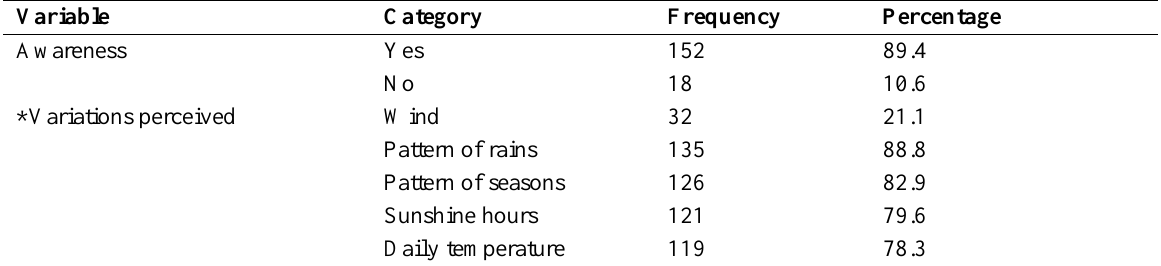
Table 2: Respondents’ perception about climate change (N = 170).